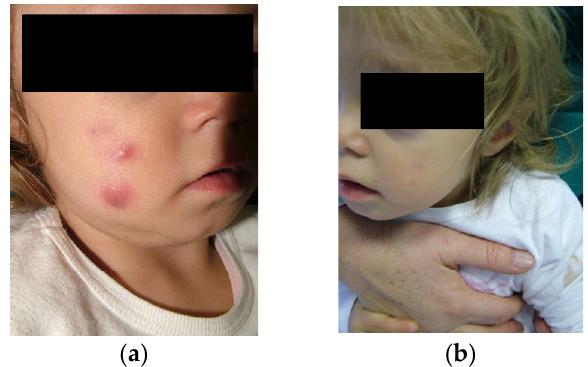
Figure 2. Skin nodules ( a ) before and ( b ) at the end of clarithromycin treatment.